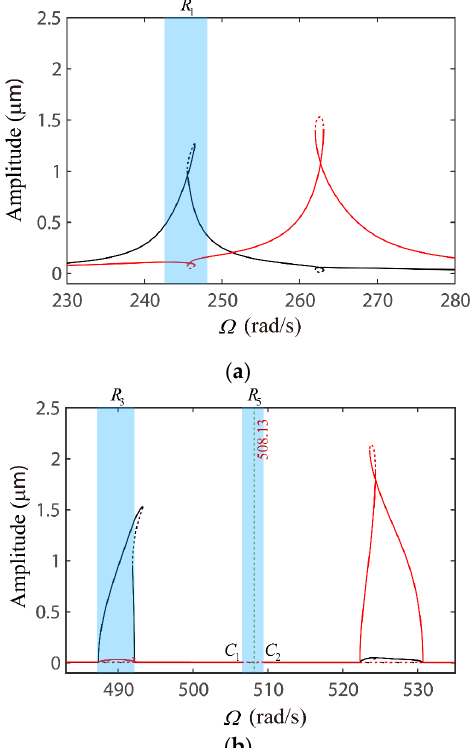
Figure 9. For δ 0 = − 1.5 μ m, frequency–response curves of ( a ) primary resonances, and ( b ) 1/2-order subharmonic resonances of the two degrees-of-freedom of the system.